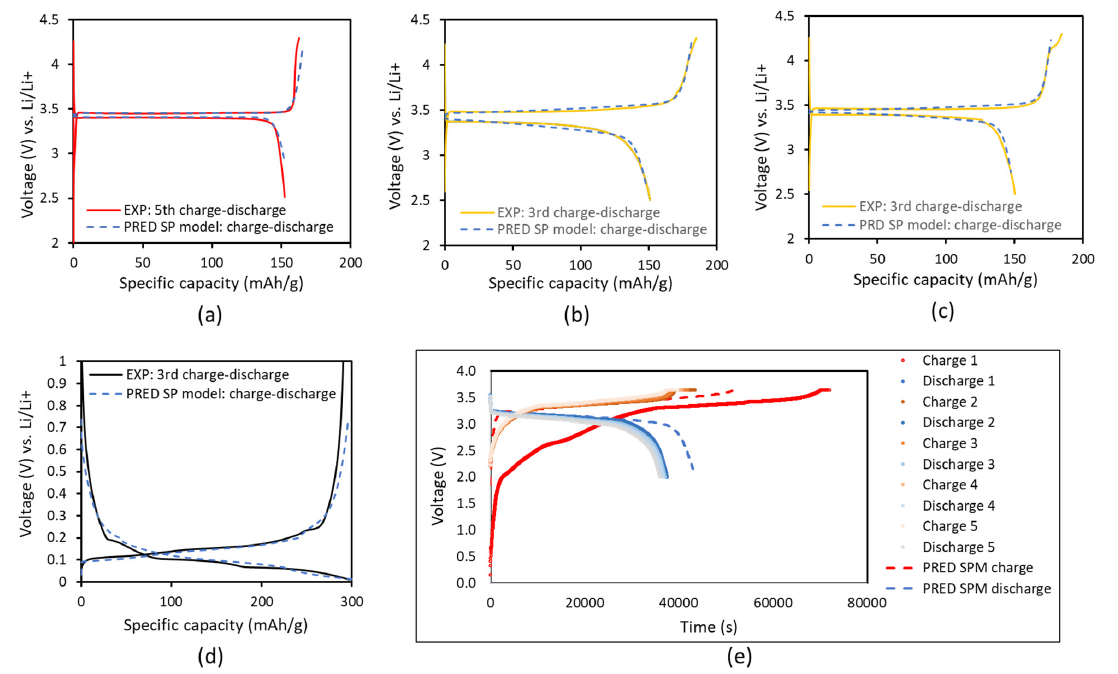
Figure 10. Plots of GCD results at 0.05 C, including predictions (PRED) from computational simulations using the SP model (broken lines) and experimental data (solid lines): ( a ) Li-LFP half- cell with PVDF binder in the cathode; ( b ) Li-LFP half-cell with KynarFlex ® PVDF 2801-00 binder in the cathode; ( c ) Li-LFP half-cell with Kynar PowerFlex ® LBG binder in the cathode; ( d ) graphite-Li half-cell with PVDF binder in the anode; ( e ) graphite-LFP battery cell with Kynar PowerFlex ® LBG binder in the cathode and PVDF binder in the anode.